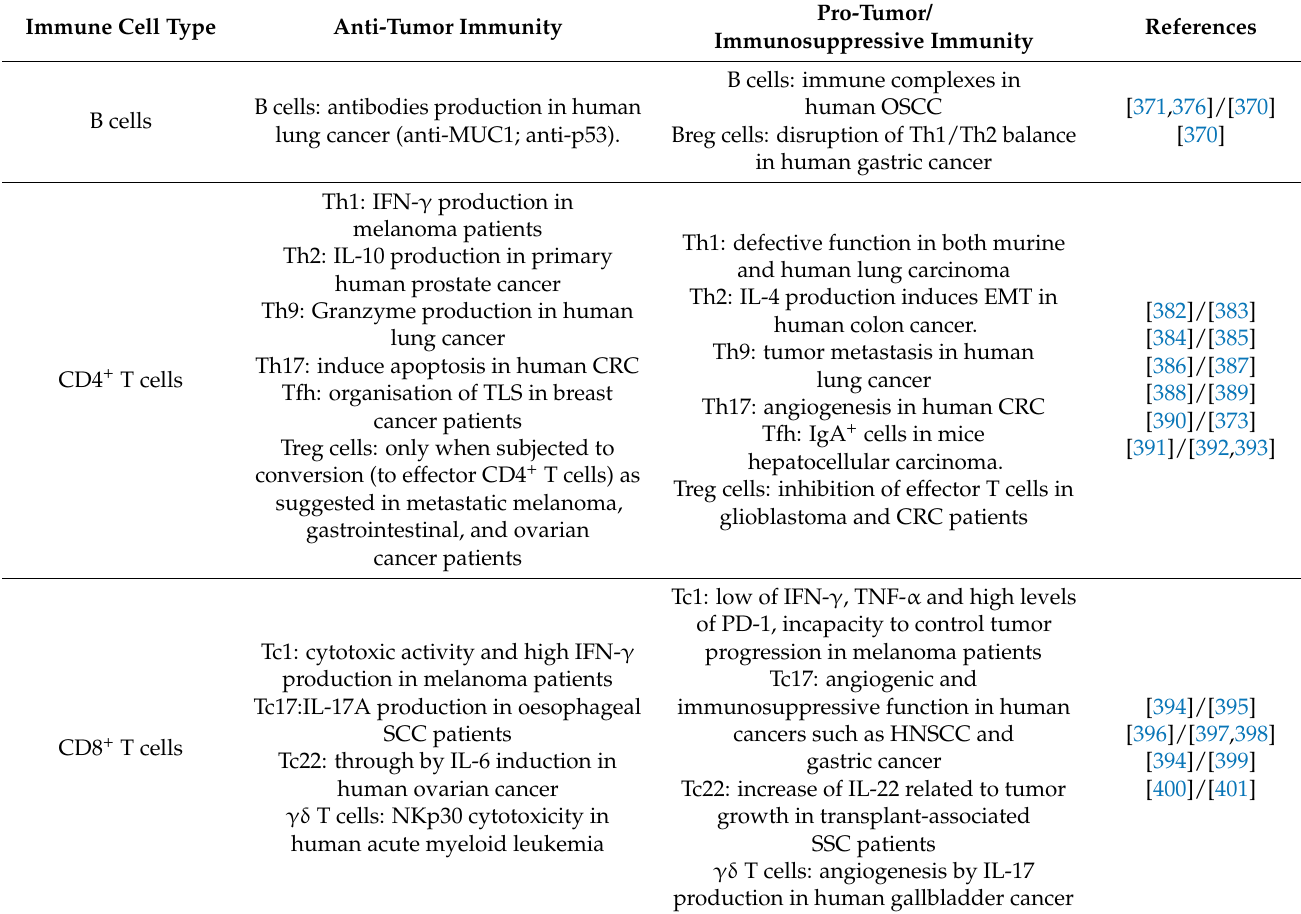
Table 2. Adaptive immunity. Anti-and pro-tumor functions of the immune cells in different cancer